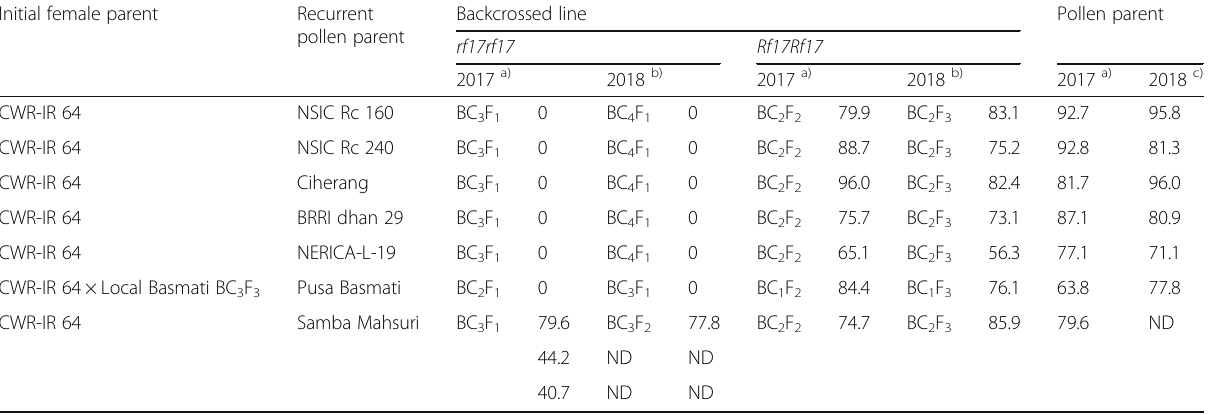
Table 1 Seed setting rates (%) of backcrossed lines and pollen parents in 2017 and 2018 Initial female